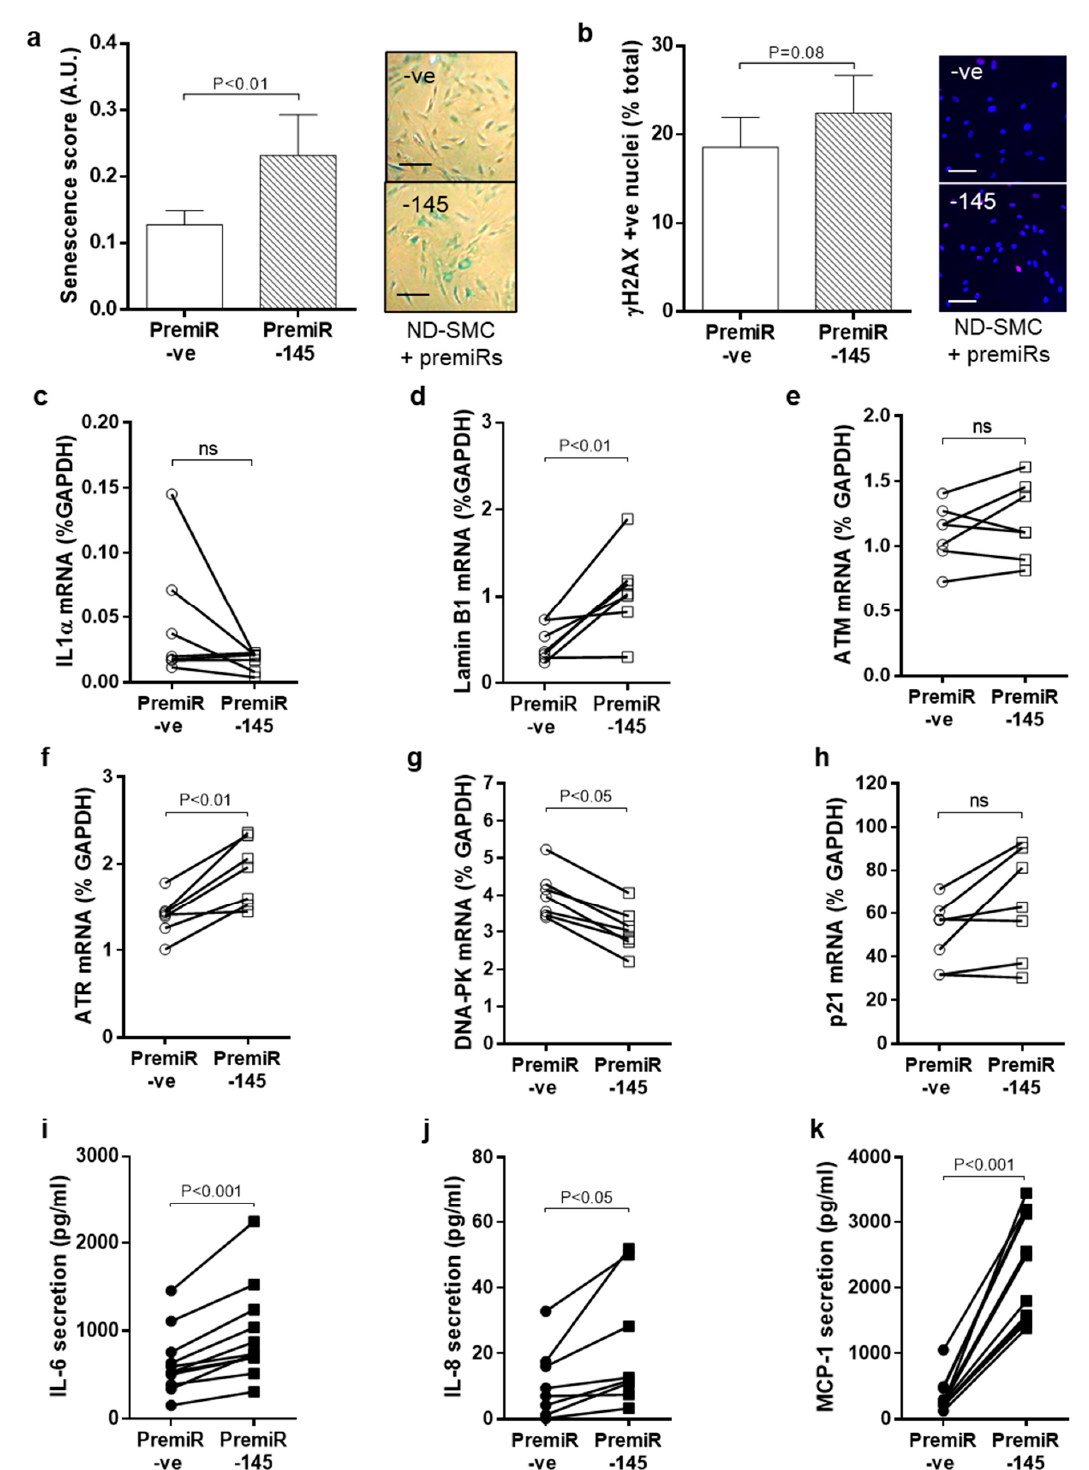
Figure 5. Effect of miRNA-145 overexpression on SMC senescence, DDR signalling and SASP. ND-SMC were transfected with premiRNA-145 or premiRNA -ve. ( a ) After 4 days in full growth media, cells were fixed and stained for SA- β -galactosidase (scale bar = 200 µ M, n = 6). ( b ) IL-1 α and ( c ) LMNB1 expression were measured by RT-PCR after 72 h ( n = 7). ( d ) Cells were treated as ( a ) and stained for γ H2AX (pink foci, scale bar = 100 µ M, n = 6). ( e ) Expression levels of ATM , ( f ) ATR , ( g ) DNA-PK and ( h ) p21 were quantified by RT-PCR 72 h after miRNA-145 transfection ( n = 7). ( i ) Protein secretion of IL-6, ( j ) IL-8 and ( k ) MCP-1 was measured by ELISA after 96 h ( n =